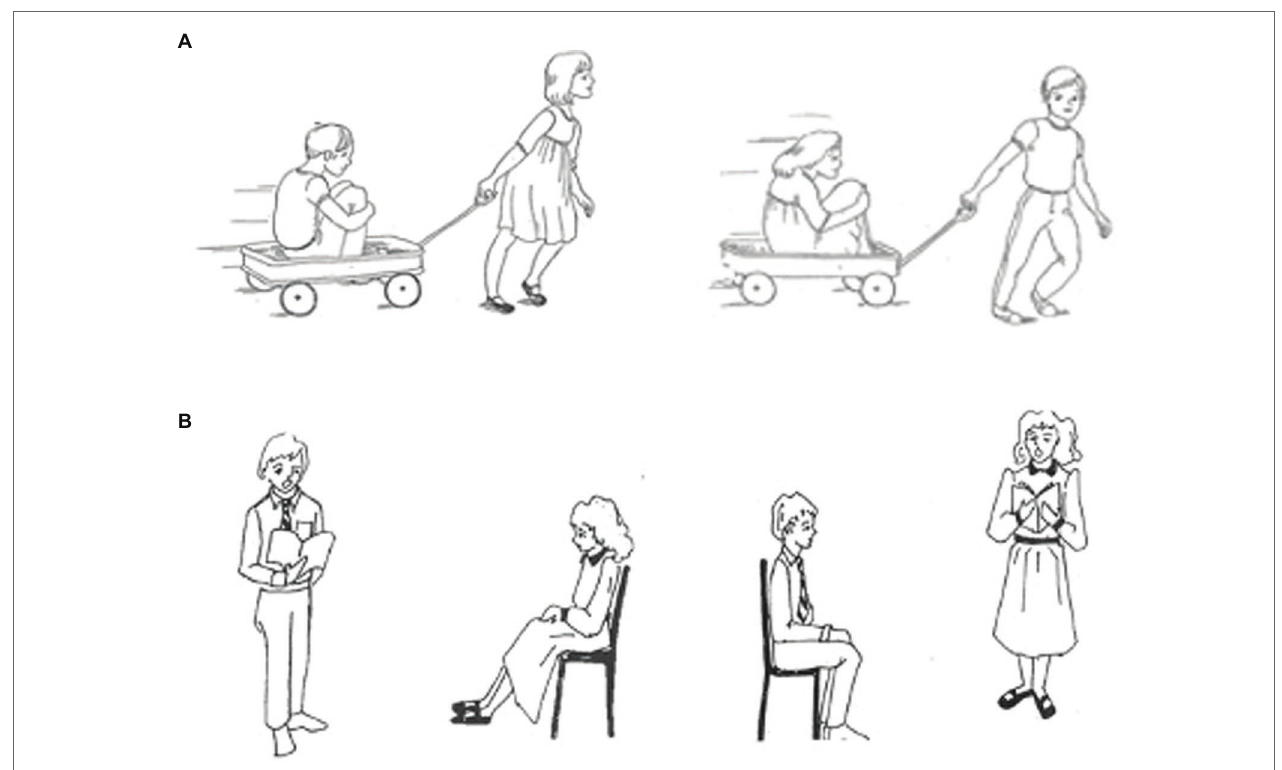
FIGURE 2 | For reversal trials for the transitive sentences in the active-passive sentence comprehension task, the incorrect picture in a set presented the incorrect (i.e., reversed) action clause. For example, “The boy pulled the girl” was presented with a picture set in which the incorrect picture portrayed the girl pulling the boy (A) . For reversal trials for the dative sentences, the incorrect picture depicted the reversal of the relationship between the agent and the indirect object. For example, “The boy read a book to the girl” was presented with a picture set where the incorrect picture portrayed the girl reading a book to the boy (B)